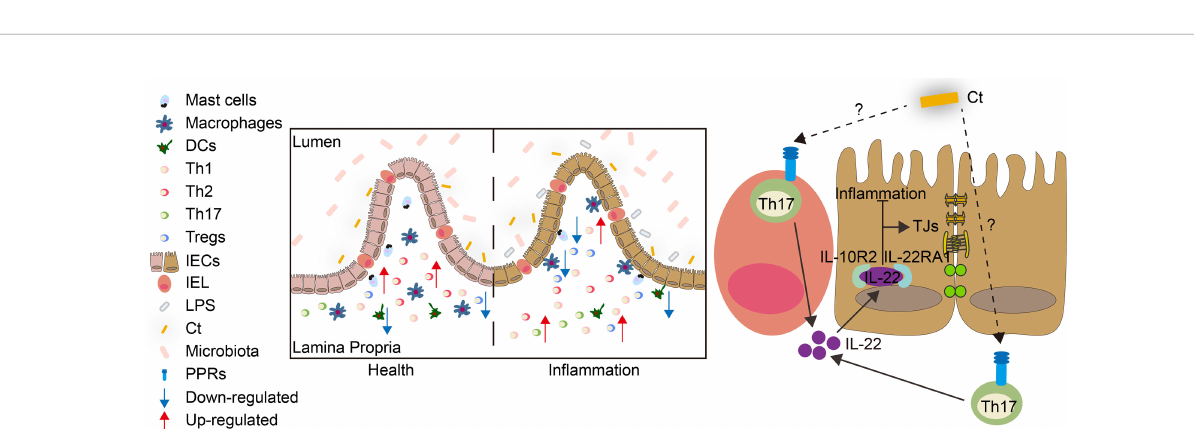
FIGURE 9 | Model for the function and mechanism of Ct in regulating intestinal health. Ct inhibited LPS-induced intestinal in fl ammation in the ileum. The protective role of Ct in the ileum presented an IL-22-dependent manner in vivo . In response to LPS, Ct enhanced the proportions of Th17 cells to produce IL-22, which combined with IL-22RA1 expressed in the epithelial cells, thereby maintaining the barrier function and alleviating in fl ammation in the